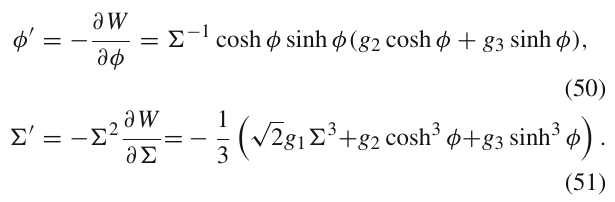
Table 1 Scalar masses at the N = 4 supersymmetric AdS 5 critical point with U ( 1 ) × SU ( 2 ) × SU ( 2 ) symmetry and the corresponding dimensions of the dual operators